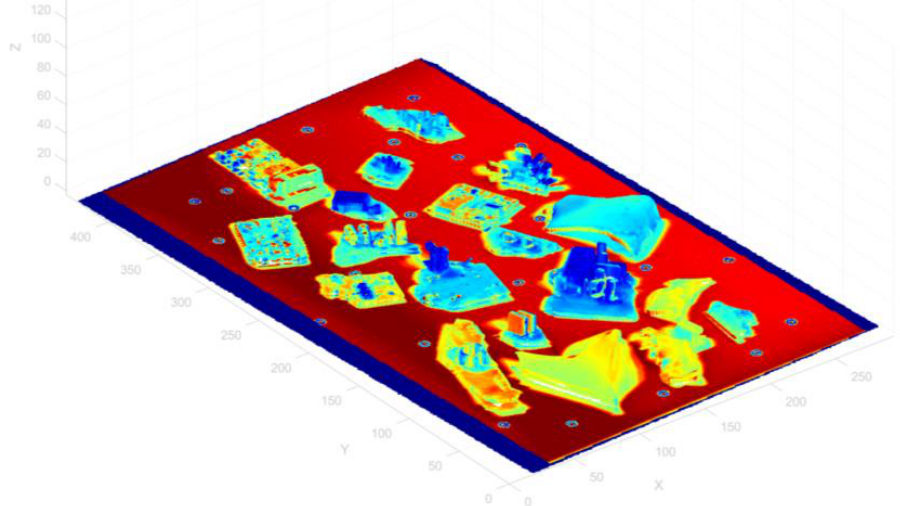
Figure 4. Combined 3D point cloud and HSI. Each 3D point is assigned by a spectrum. In this figure, the average value over the entire spectrum is shown per